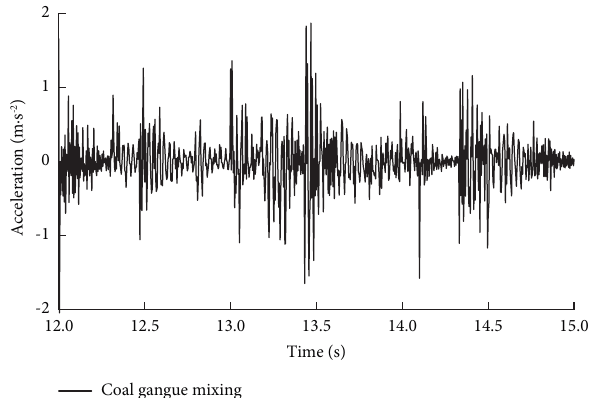
Figure 12: Vibration signal of the tail beam in 12 ∼ 15s stage.